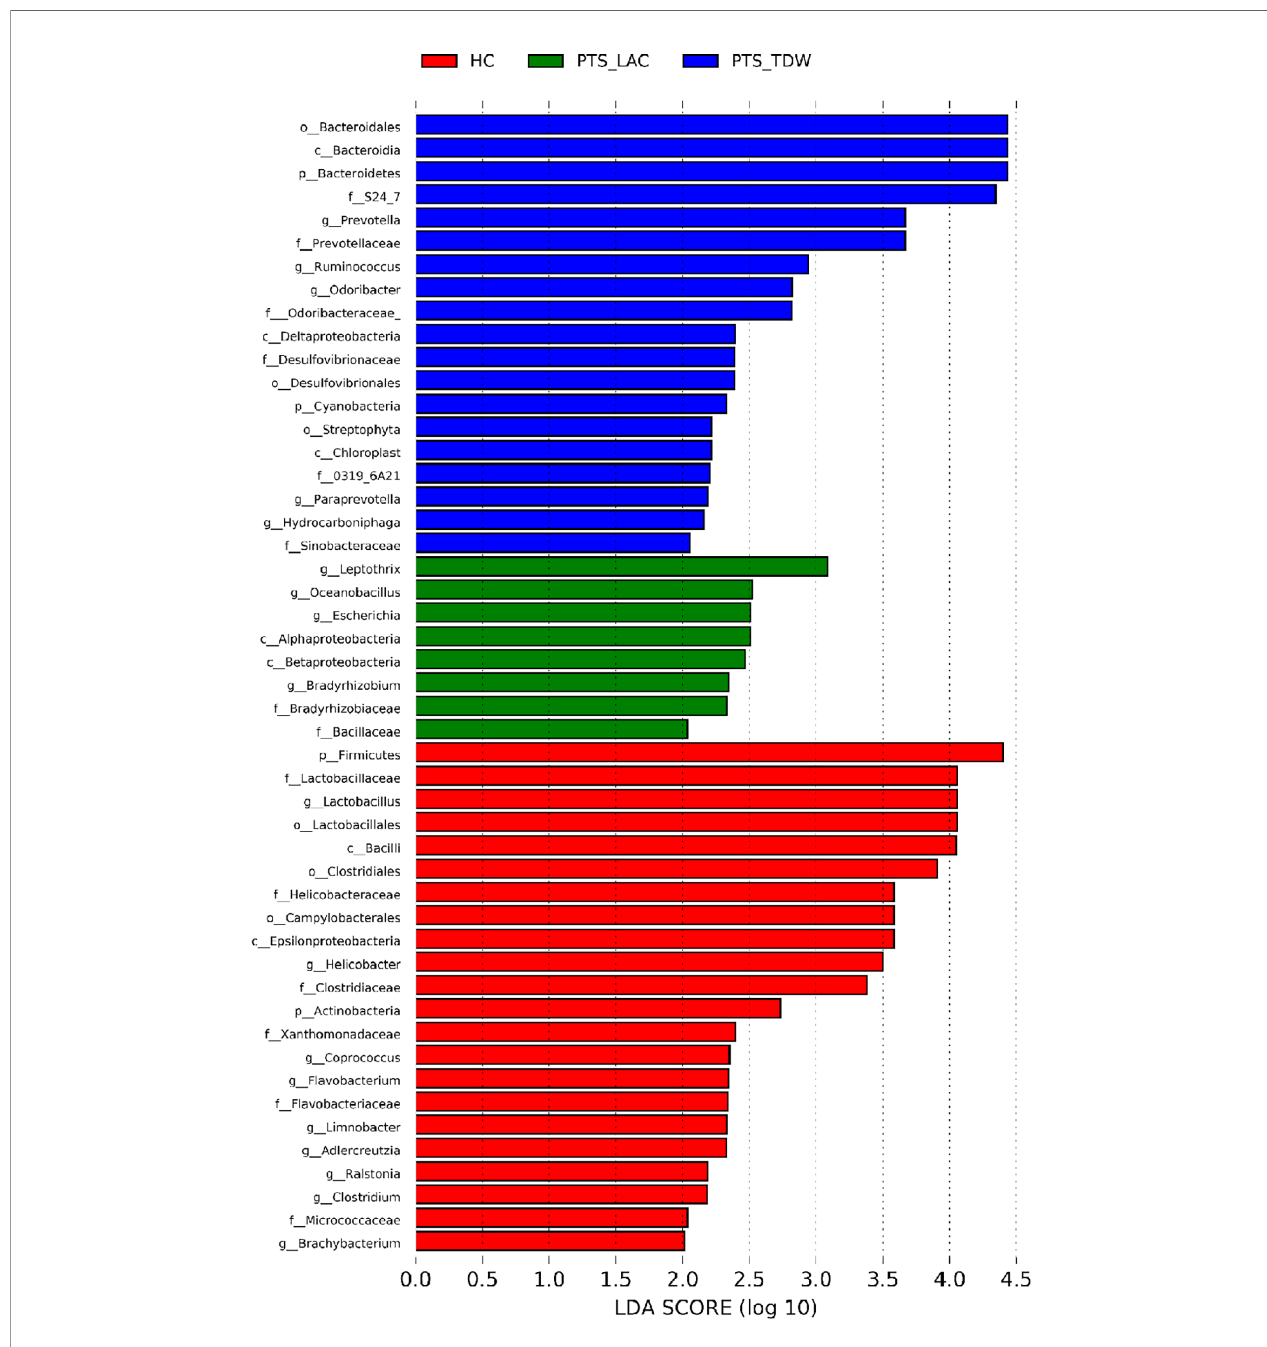
FIGURE 5 | Linear discriminant analysis (LDA) was used to analyze biomarker taxa (LDA scores ≥ 2) in the three